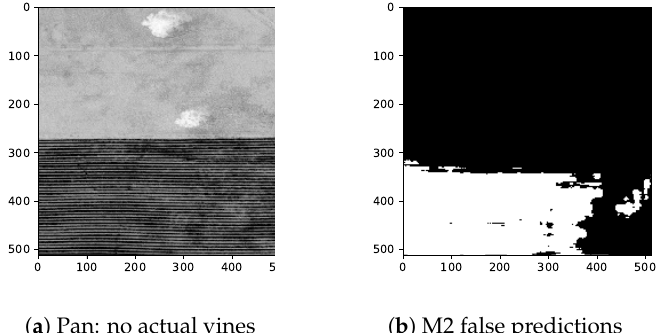
Figure 7. An example patch of size 512 × 512 pixels for M2 with false detections, JI = 0%, Precision = 0%, Recall =